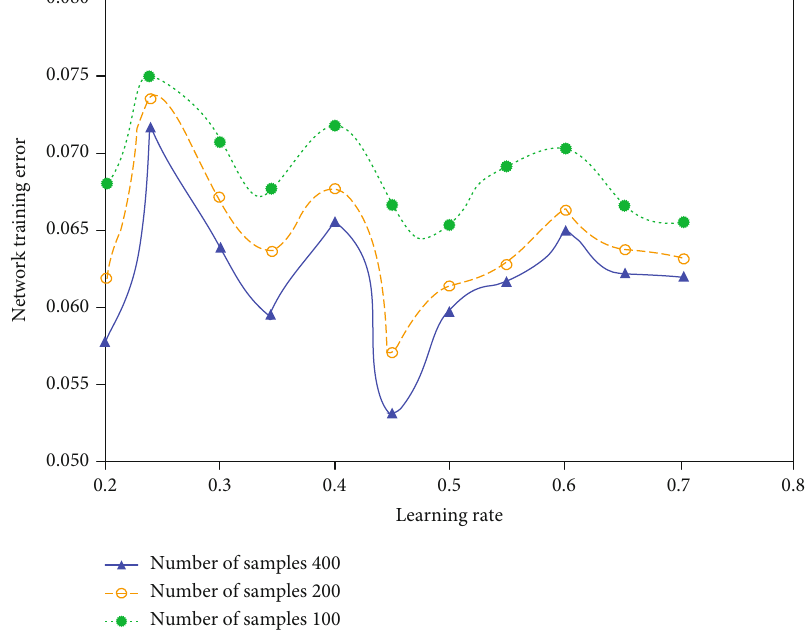
Figure 6: Network training error corresponding to di ff erent learning